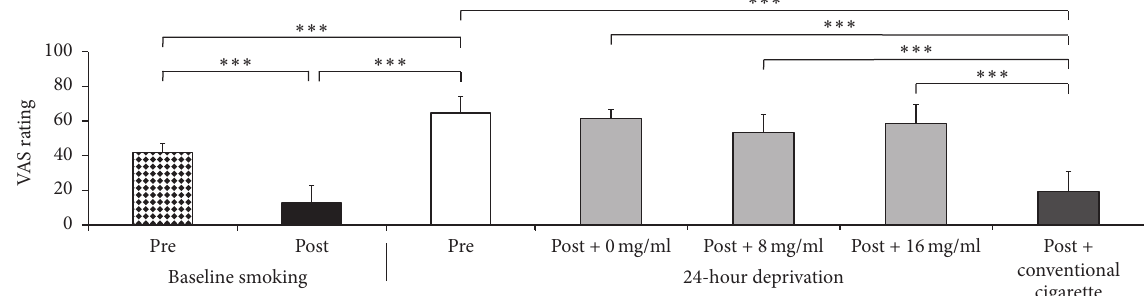
Figure 1: Self-report of “I have a desire for a cigarette right now.” Subjective ratings of “I have a desire for a cigarette right now” on a 100- point Visual Analog Scale. A significant decrease was observed following baseline session smoking and a significant increase was observed following 24h tobacco deprivation. Ratings prior to CC (own brand) or EC use during deprivation sessions were also significantly higher than presmoking ratings during baseline sessions. Following cigarette administration during deprivation sessions, CC engendered significantly lower ratings compared to EC dispensing aerosol from 0, 8, or 16mg/ml nicotine concentrations. ∗∗∗ p <